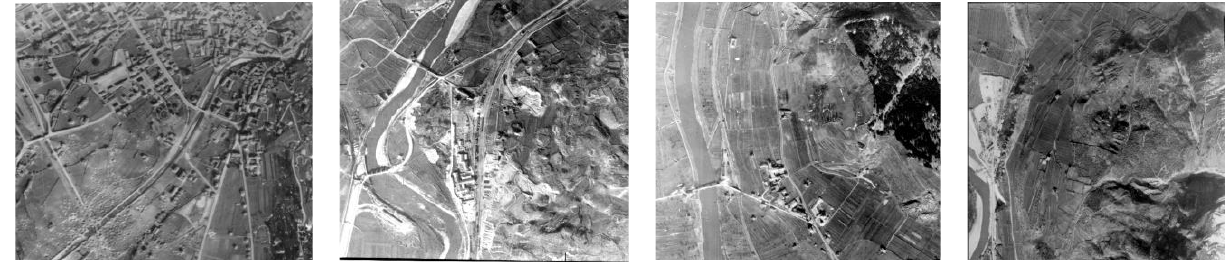
Figure 1. Examples of grayscale photos acquired from aerial platforms between 1944 and 1945 in Italy.